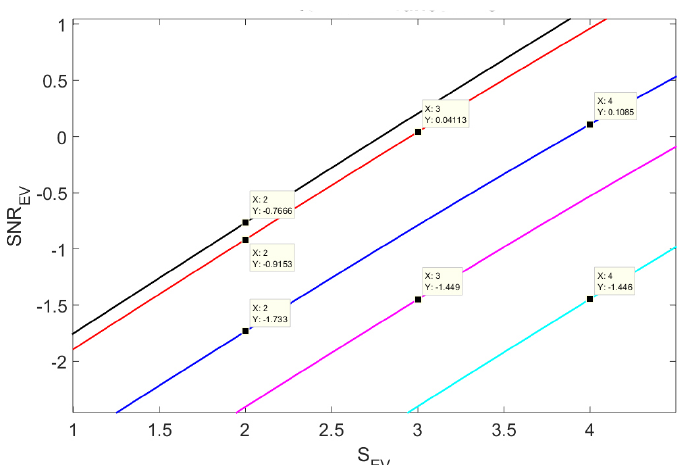
Figure 4. Detail of shadows area in Figure 3. Black, ISO 100; red, ISO 200; blue, ISO 800; magenta, ISO 1600; cyan, ISO